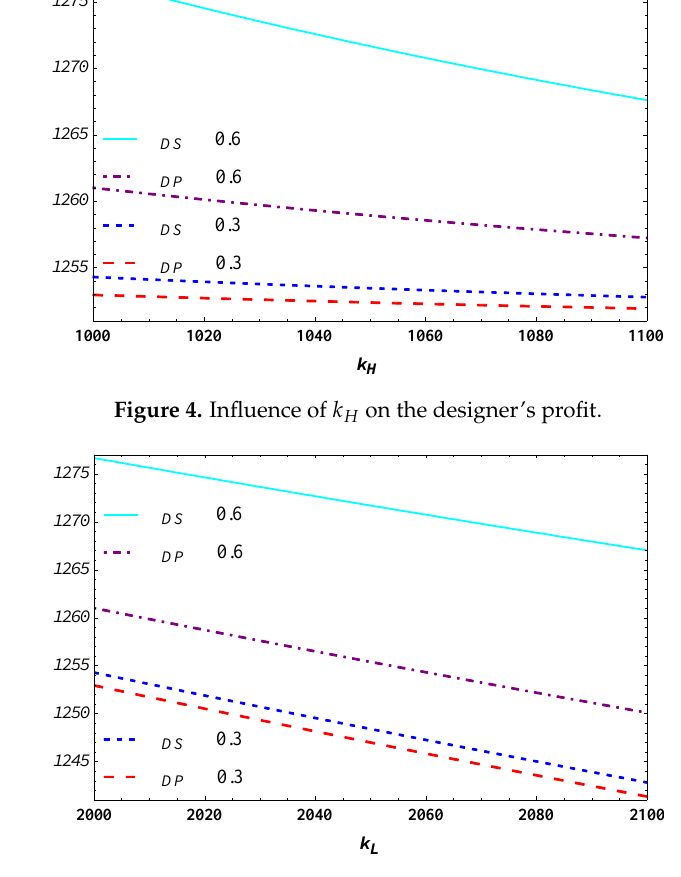
k on the designer’s profit. Figure 5. Influence of k L L on the designer’s